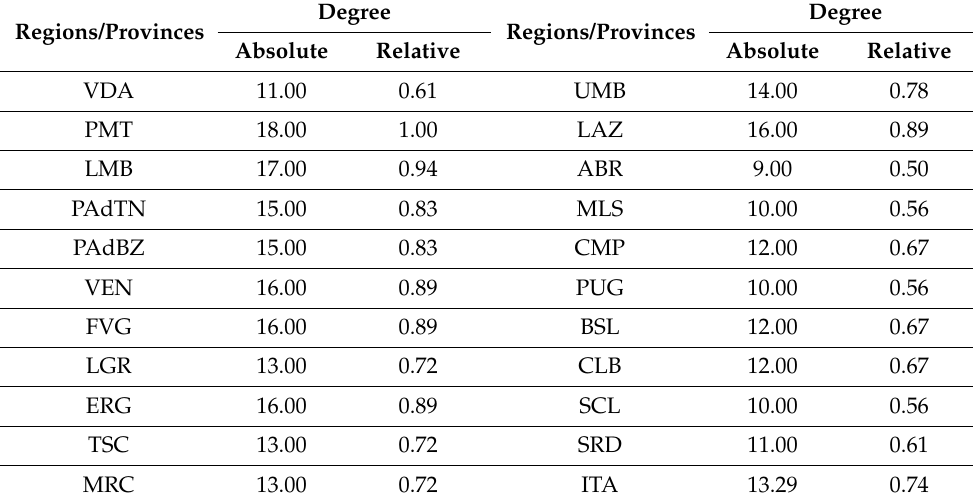
Table 4. Absolute and relative degree of digitisation of R&PAs and